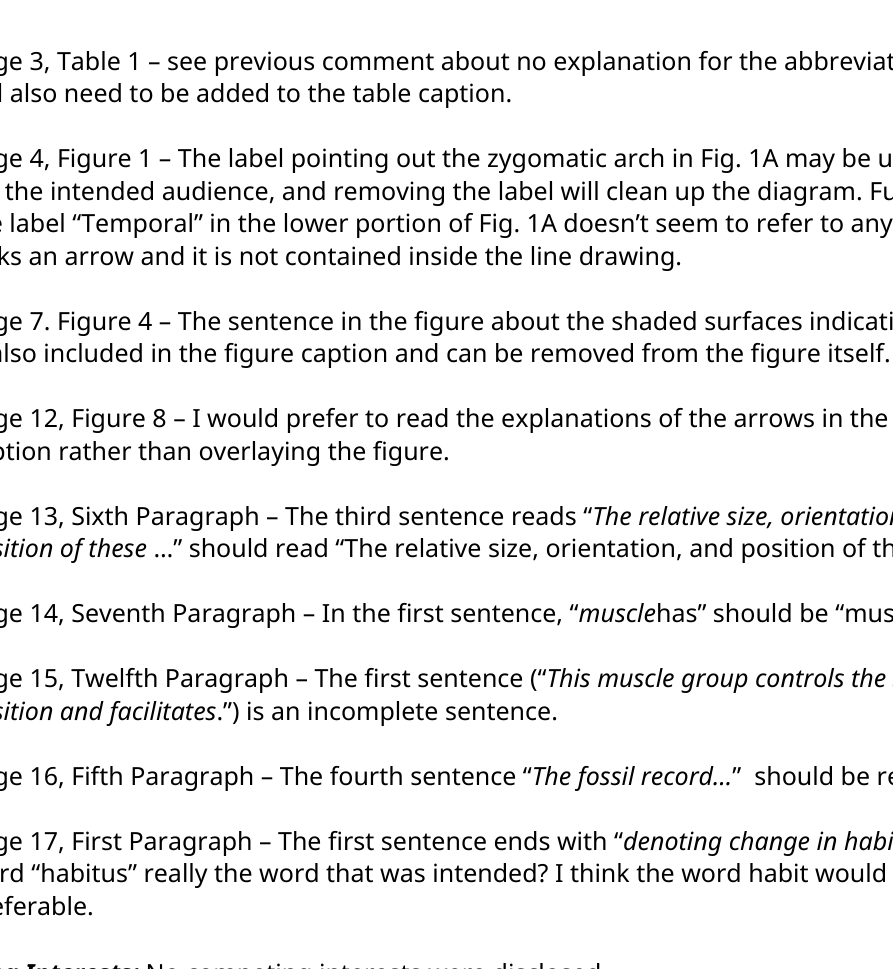
Page 7. Figure 4 – The sentence in the figure about the shaded surfaces indicating occlusion is also included in the figure caption and can be removed from the figure